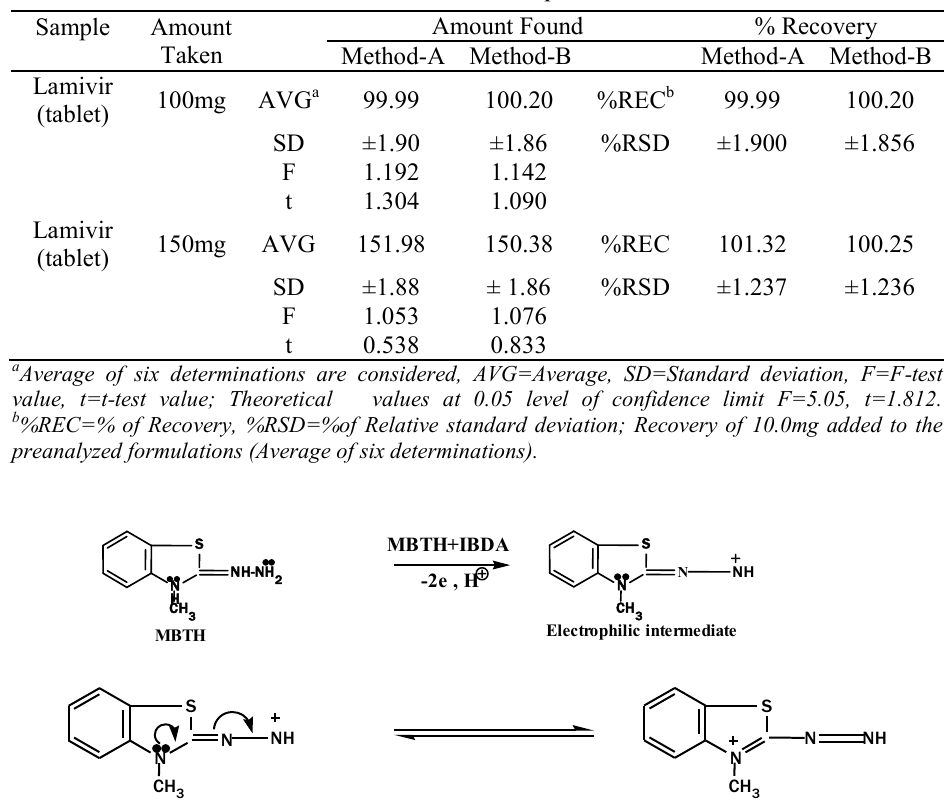
Table 2. Determination of Lamivudine in pharmaceutical formulations.